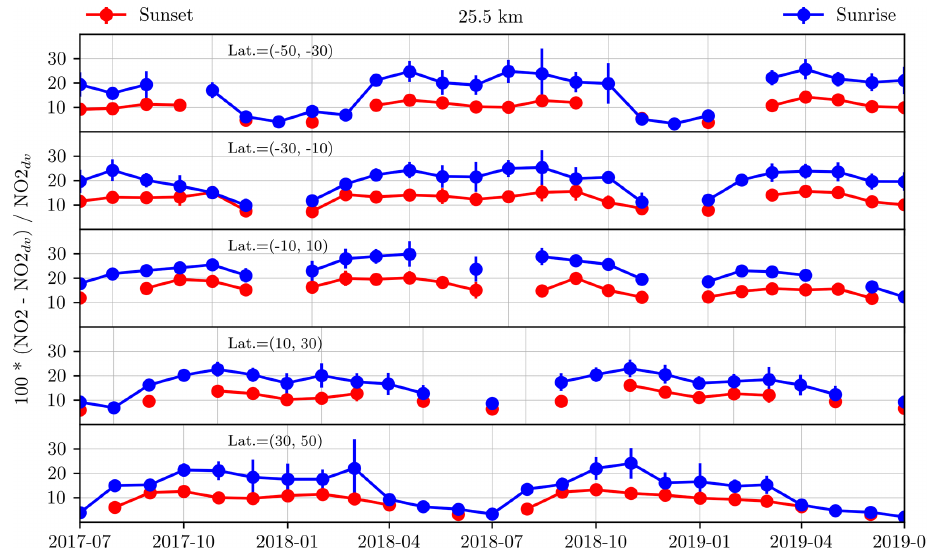
Figure 8. Mean difference between the SAGE v5.1 and diurnally varying (dv) retrievals for SAGE III/ISS sunset and sunrise NO 2 at 25.5km. The error bars are the standard